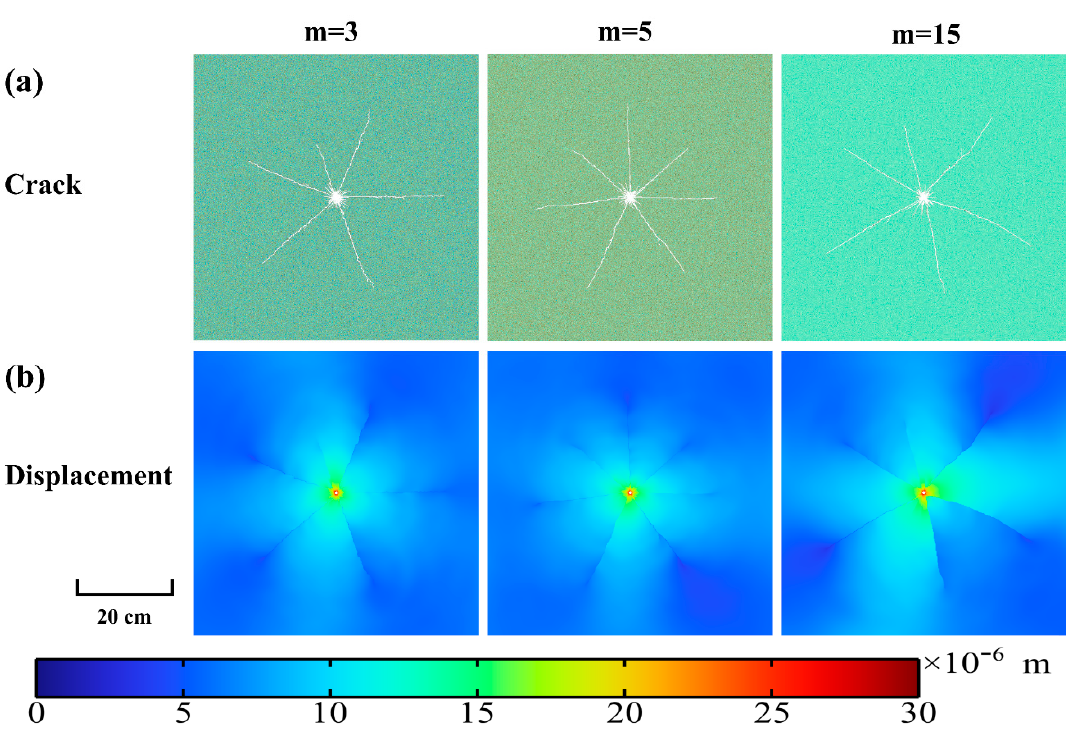
Figure 22. ( a ) Distribution of final cracks and ( b ) cloud diagrams of final displacement in granite under electropulse for different homogeneity indices m = 3, 5, 15.